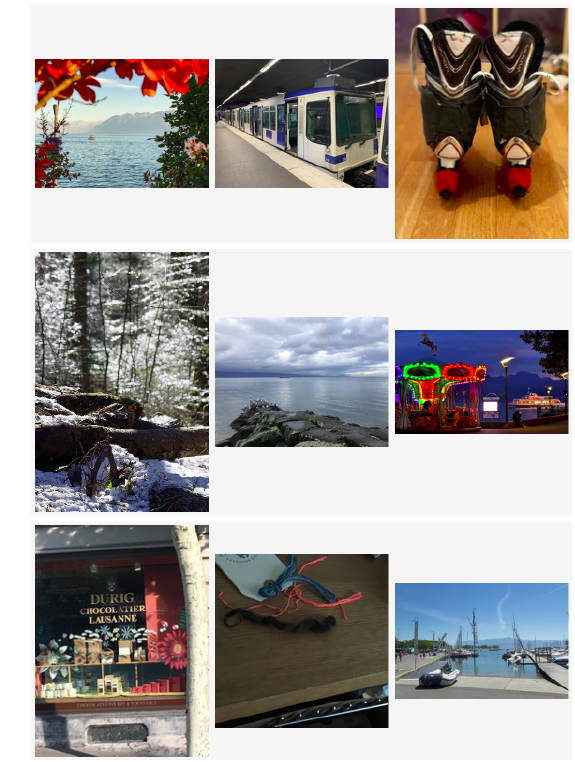
Figure 6: Illustration of some photos taken by FlickR